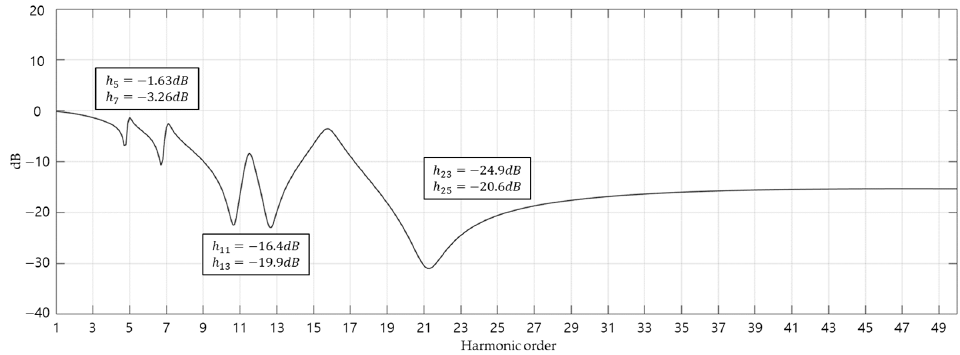
Figure 4. Frequency response of H id ( s ) .